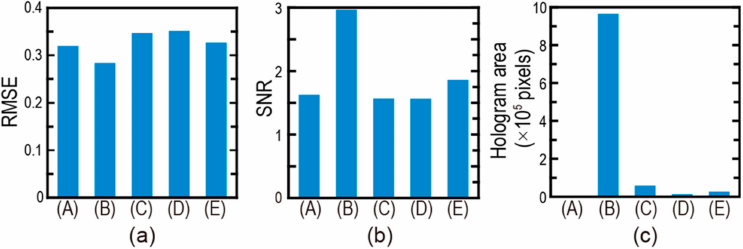
Figure 3. Comparison of the ( a ) root-mean-square error (RMSE), ( b ) signal-to-noise ratio (SNR), and ( c ) hologram area of the CGBHs. The data labels of (A)–(E) correspond to the labels in Figure